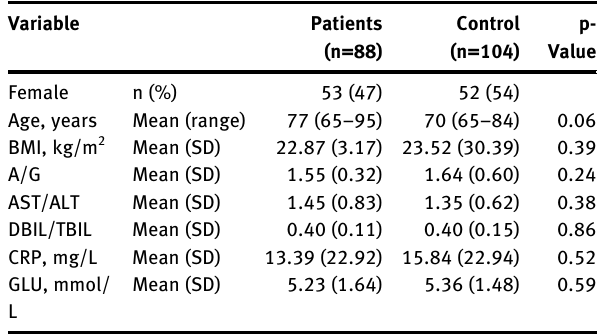
Table  : Baseline characteristics and biochemical indexes screening results of patients with sarcopenia and